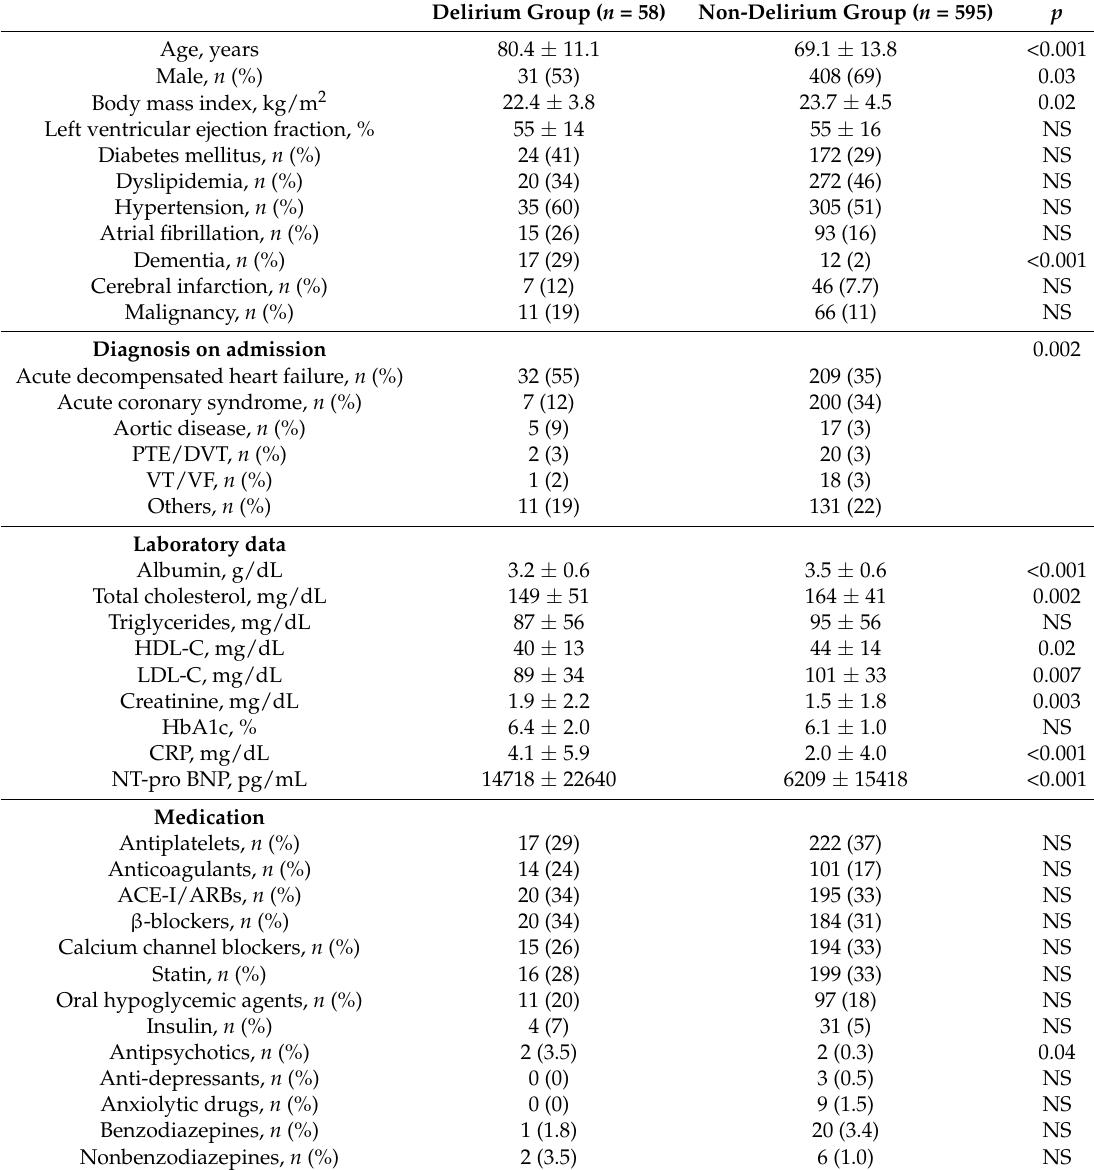
Table 1. Characteristics of the study